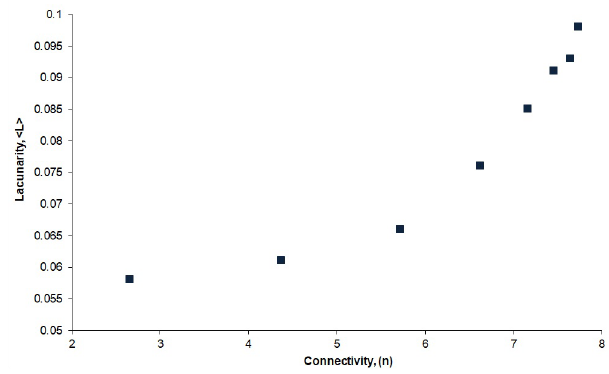
Figure 8. Lacunarity vs. Connectivity plot for deterministic fractal- fracture patterns ( i = 1 to 8).